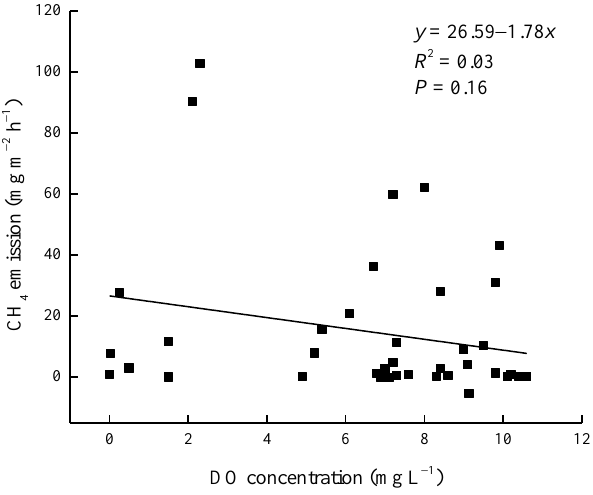
Figure 7. The correlation between CH 4 emissions and dissolved oxygen concentration.